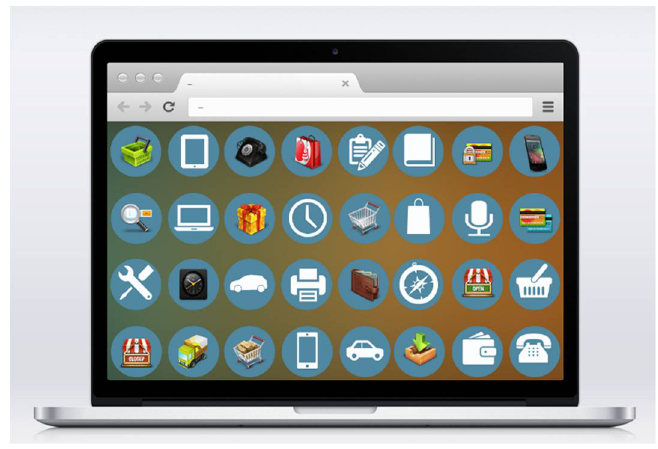
Figure 6. Screen displayed to users in Step 6 (click on the calendar icon).